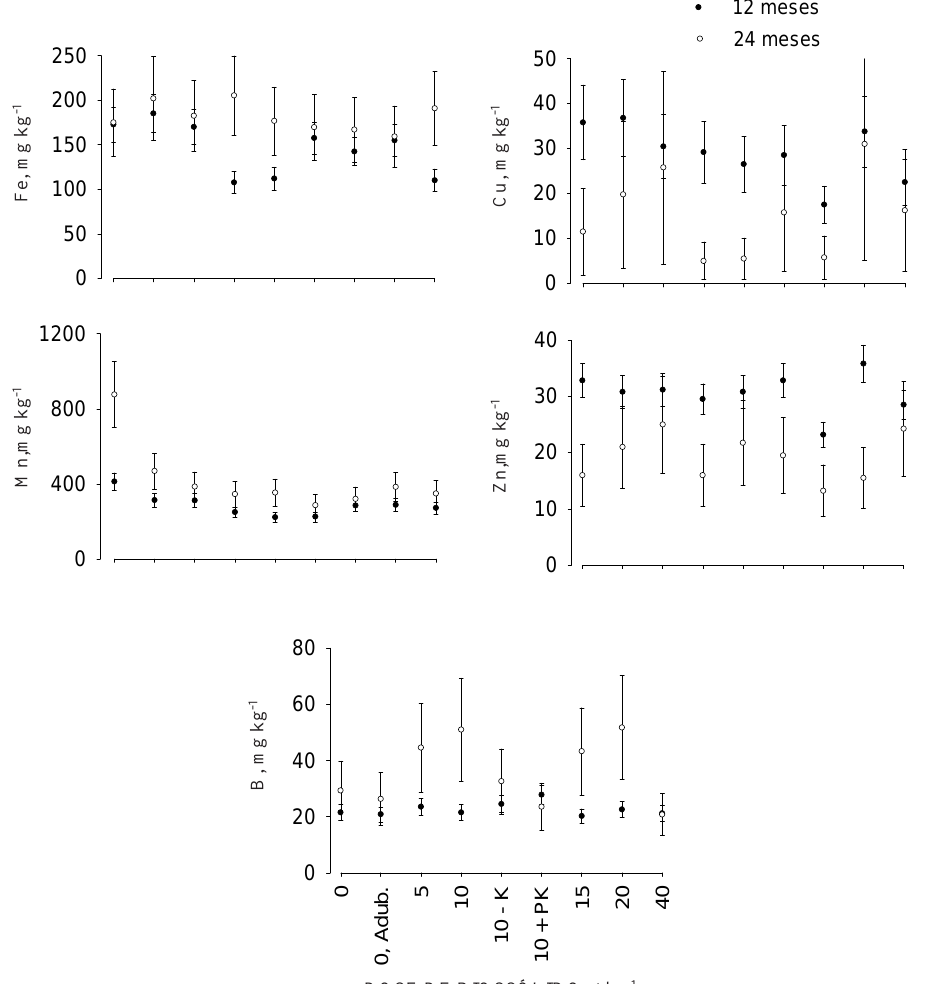
Figura 5. Concentração foliar de micronutrientes (média ± erro-padrão) aos 12 e 24 meses de idade das plantas de Eucalyptus grandis , 8 e 20 meses pós-aplicação do biossólido, em resposta às doses crescentes de biossólido, com suplementação de K (biossólido + KCl = 165 kg ha -1 de K), às aplicações de 10 t ha -1 de biossólido, sem suplementação de K e com suplementação de K e P, e à adubação mineral sem